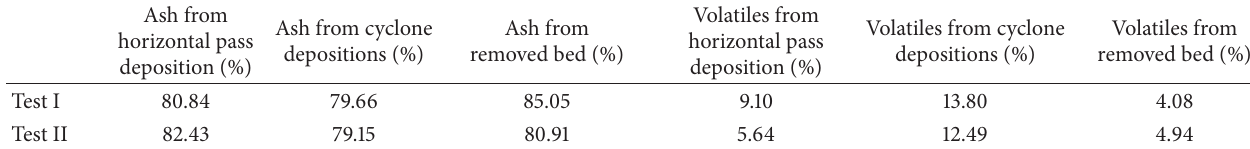
Table 3: Ash and volatile analysis of depositions from horizontal pass, from cyclone, and from removed bed for tests I and II.